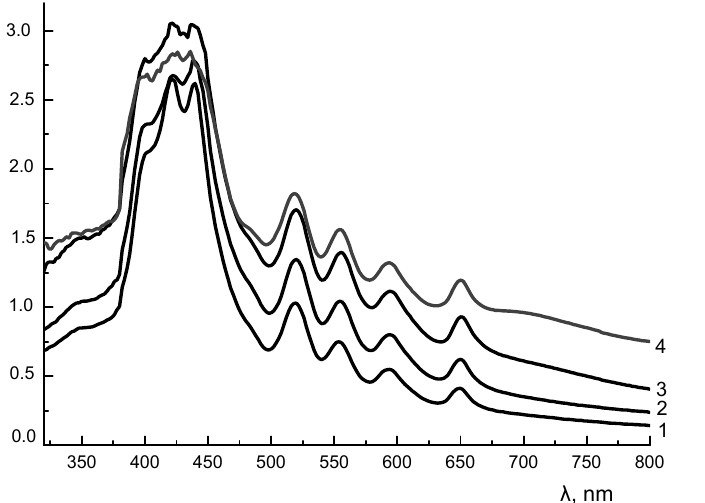
Figure 6. UV-vis spectra of PLA–TPP4OC 6 composites with TPP4OC 6 content, wt.%: 0.2 (1), 0.3 (2), 0.4 (3), and 0.5 (4).